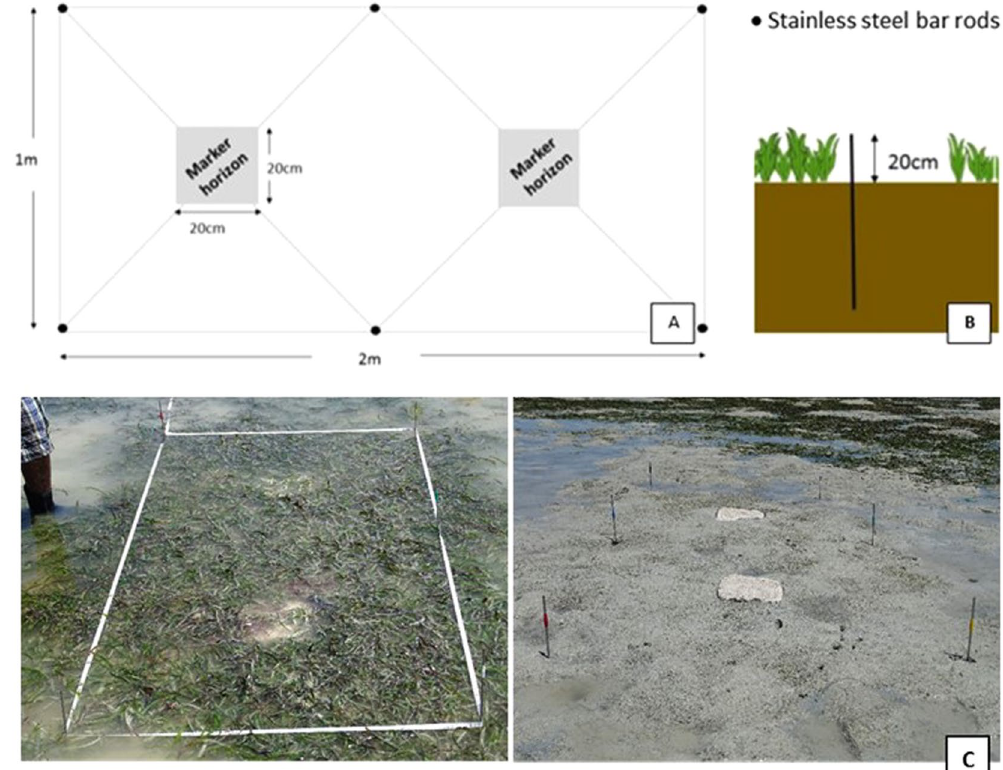
Figure 5. ( A ) Top view of the SECP plot layout, ( B ) Vertical position of rods, ( C ) Seagrass and unvegetated (control) plots set-up in